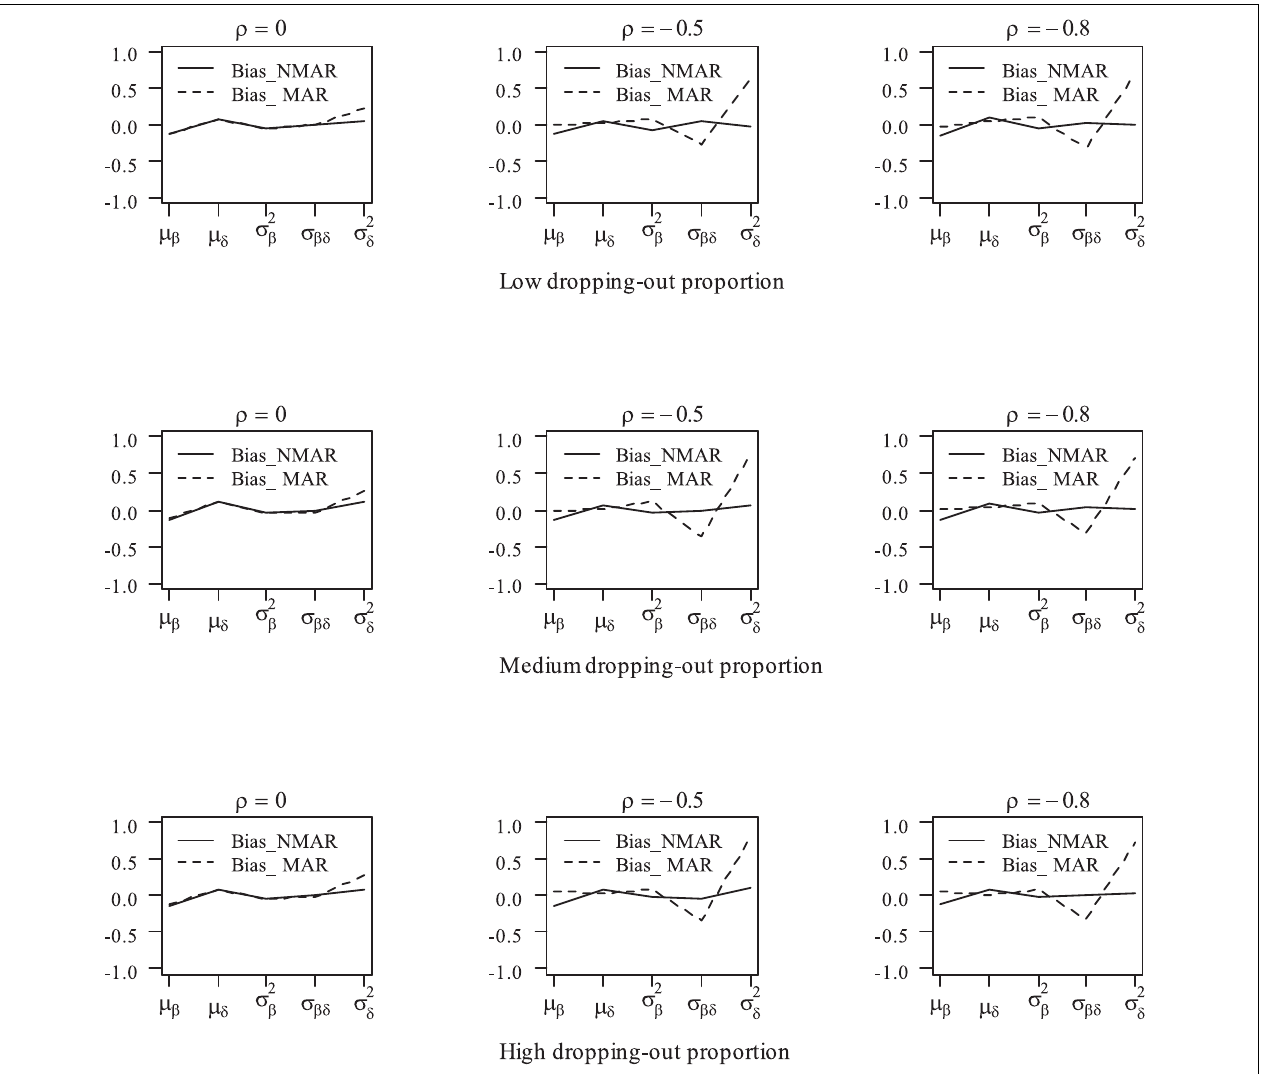
FIGURE 3 | Bias of parameter estimates in the mean item vector and the item covariance matrix elements under different dropping-out proportions and correlations between θ h i and θ d i in simulation study III. Note that the Bias_NMAR is the bias of parameter estimates in NMAR model, and Bias_MAR is the bias of parameter estimates in the MAR